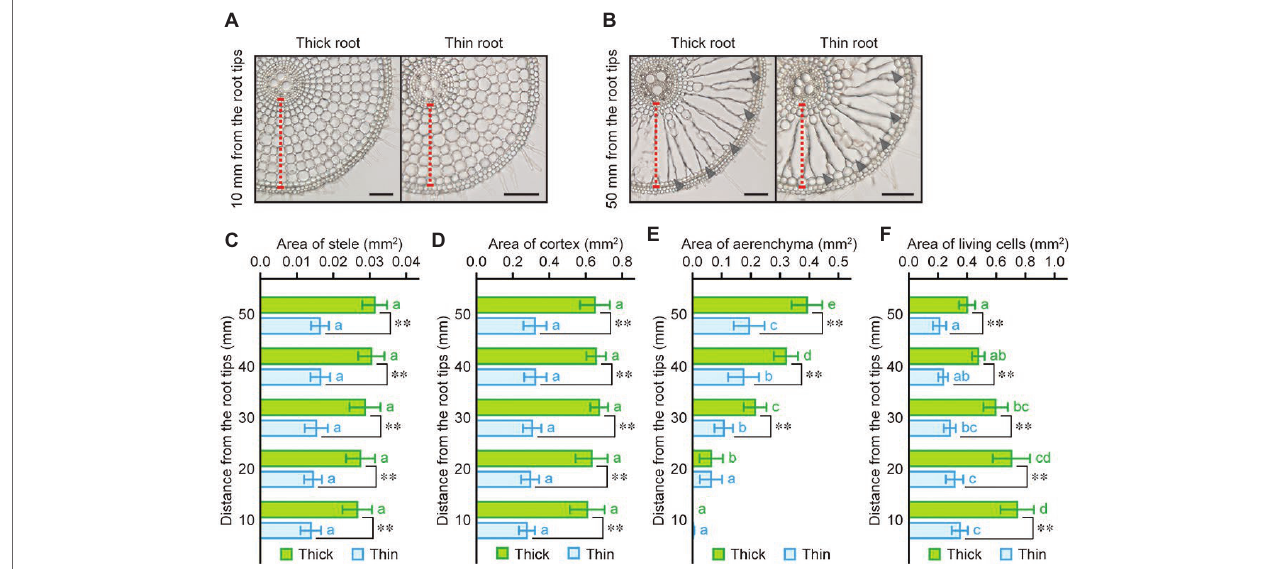
FIGURE 4 | Size of each tissue in thick and thin adventitious roots of rice. Cross sections at 10 mm (A) and 50 mm (B) from the tips of thick and thin adventitious roots of rice under stagnant conditions. Cortex cell layers and lysigenous aerenchyma are indicated by red dashed lines and black arrowheads, respectively. Bars = 100 μ m. Area of stele (C) , cortex (D) , aerenchyma (E) , and living cells (F) at 10, 20, 30, 40, and 50 mm from the tips of thick and thin adventitious roots of rice seedlings under stagnant conditions. Nine-day-old rice seedlings were further grown under stagnant conditions for 14 days. Significant differences between thick and thin roots at p < 0.01 (two-sample t -test) are denoted by ∗∗ . Different lowercase letters denote significant differences among different positions of roots ( p < 0.05, one-way ANOVA and then Tukey’s test for multiple comparisons). Values are means ± SD ( n =